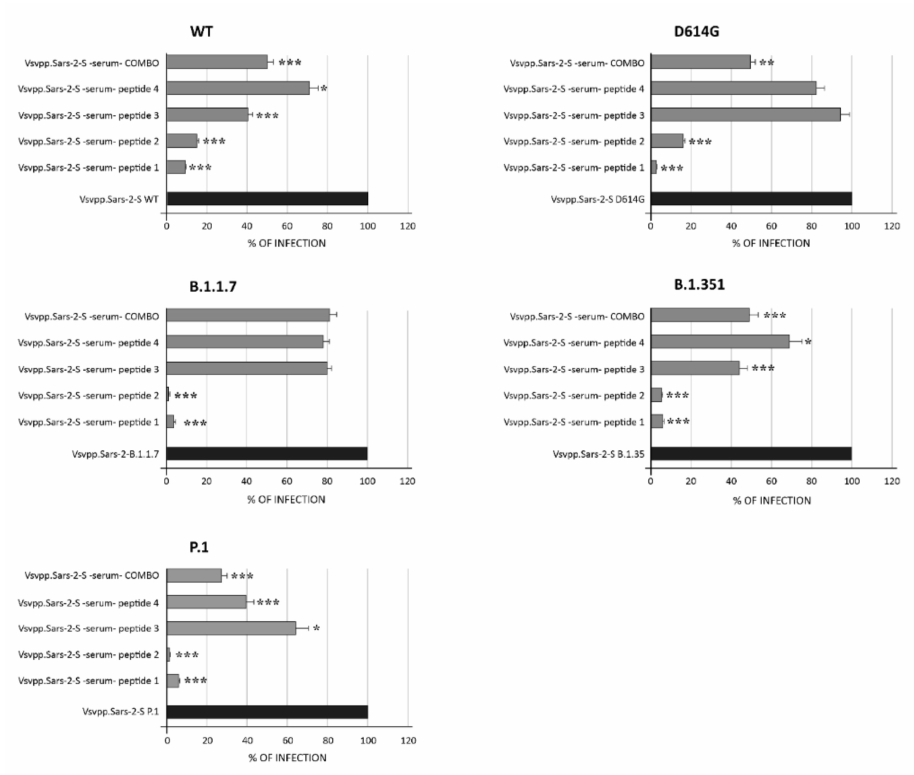
Figure 6. Neutralizing activity of IgG elicited by spike RBD peptides. VeroE6 cells were incubated with pseudotypes particles bearing the S proteins of the indicated Vsvpp.SARS-2-S WT or variants (i.e., D614G, B.1.1.7, P1, B.1.351) and together with serum containing antibodies elicited by spike peptides 1, 2, 3, or 4, or their combination. Transduction efficiency was quantified by measuring virus-encoded luciferase activity in cell lysates at 48 h post transduction and expressed as percentage. Data presented are the average from three biological replicates. Error bars indicate the standard deviation ± SD. * p < 0.05, ** p < 0.01, *** p <